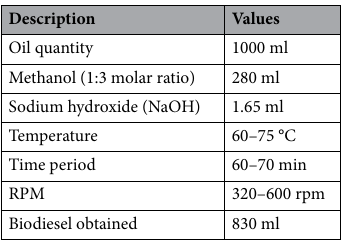
Table 1. Transesterification reaction requirement for the production of Roselle biodiesel.